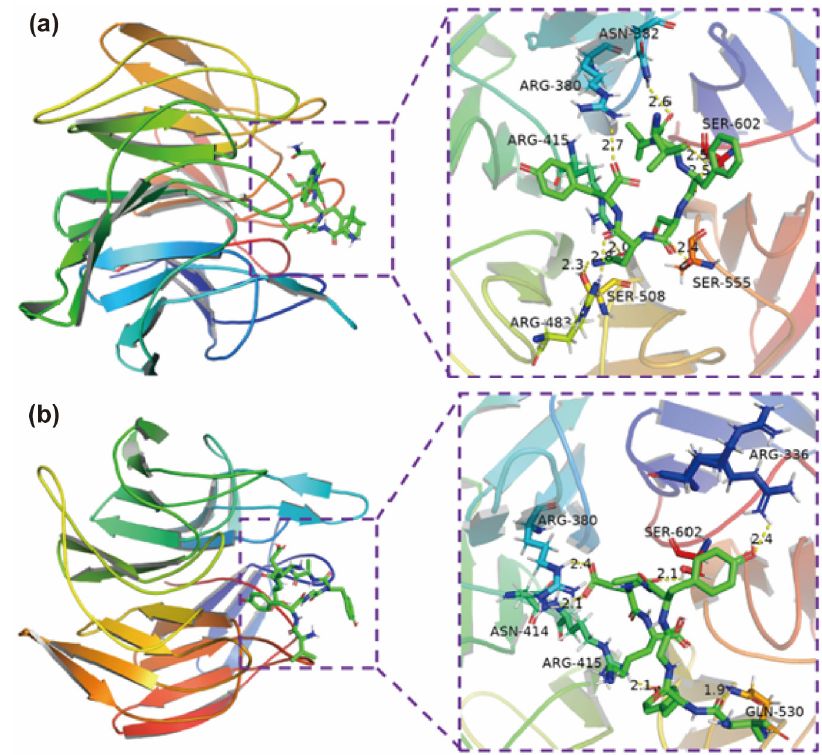
Figure 5. Molecular docking models of interactions between identified peptides and Keap1 (PDB ID: 2FLU). ( a ) The 3D molecular interactions of VLFSNY with the active site of Keap1. ( b ) The 3D molecular interactions of VYGYADK with the active site of Keap1. Table 2. Molecular docking results of identified peptides from Chinese pecan with Keap1.